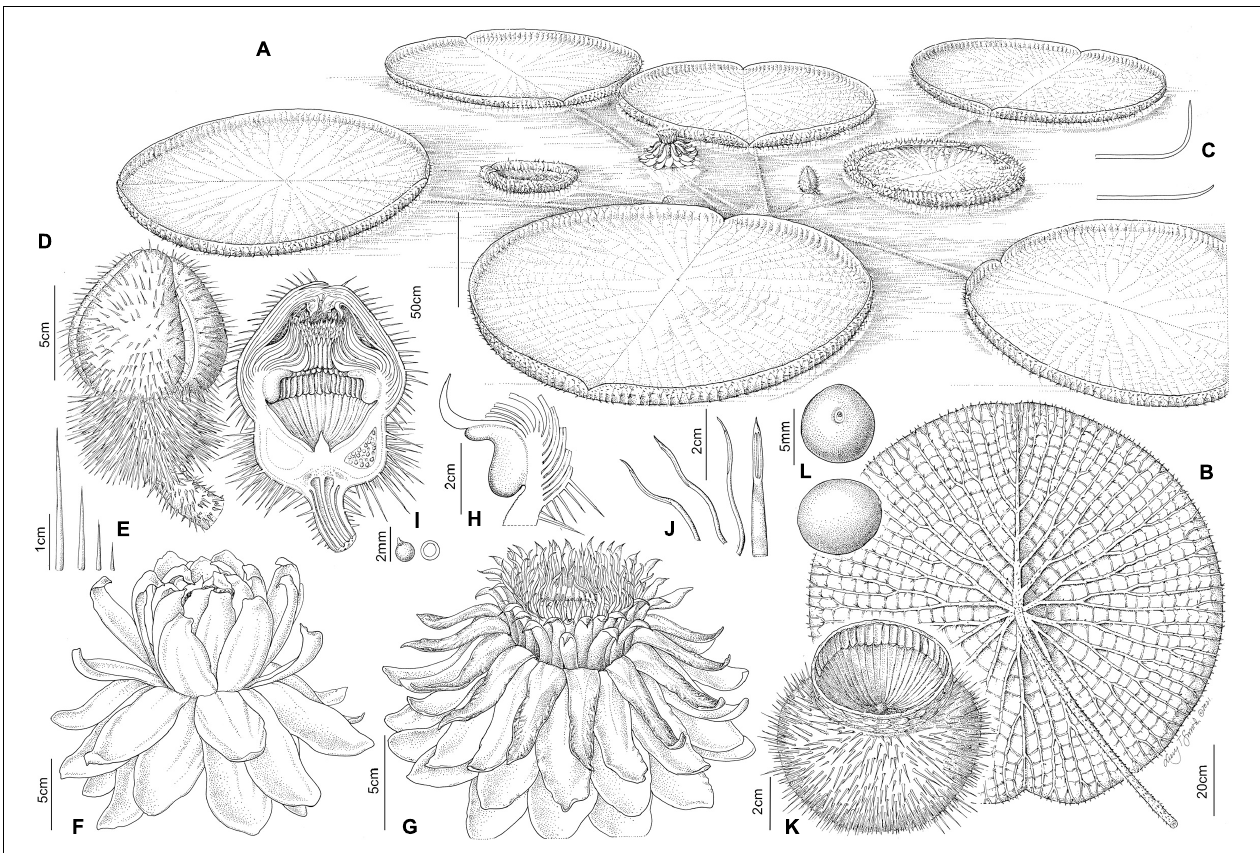
FIGURE 4 | Victoria amazonica (A) habit, (B) abaxial leaf, (C) leaf rim profiles, (D) bud, whole and LS, (E) flower prickles, (F) first night flower, (G) second night flower, (H) carpellary appendages and tepal, staminode attachments; (I) ovule, whole and LS, (J) stamens, (K) fruit, (L) seed. (All from material cultivated at RBG Kew). Illustration: Lucy T.